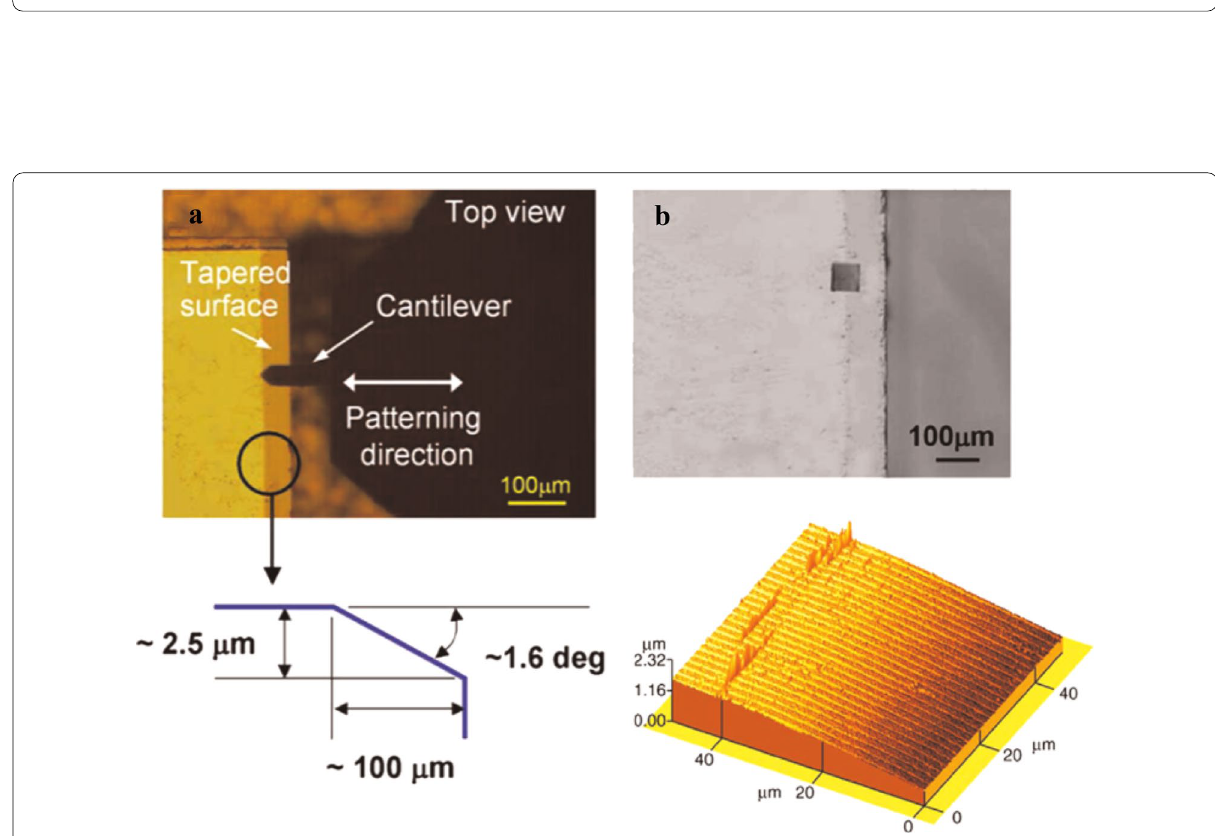
Figure 10 AFM images (top) and corresponding cross-sectional profiles (bottom) of nanoscratches created with different tip direction ( φ [56]: ( a ) before etching; ( b ) after 20 wt.% KOH-etching for 18 min